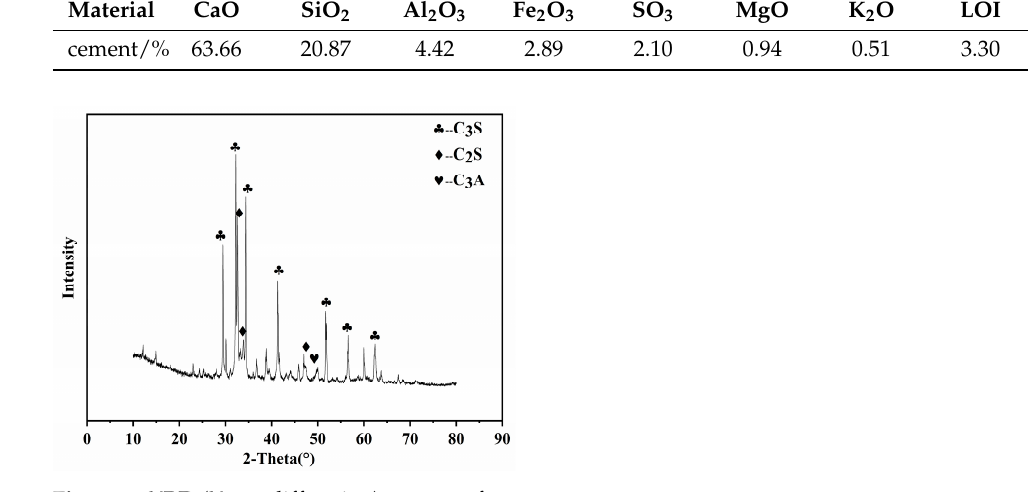
Figure 1. XRD (X-ray diffraction) pattern of cement.